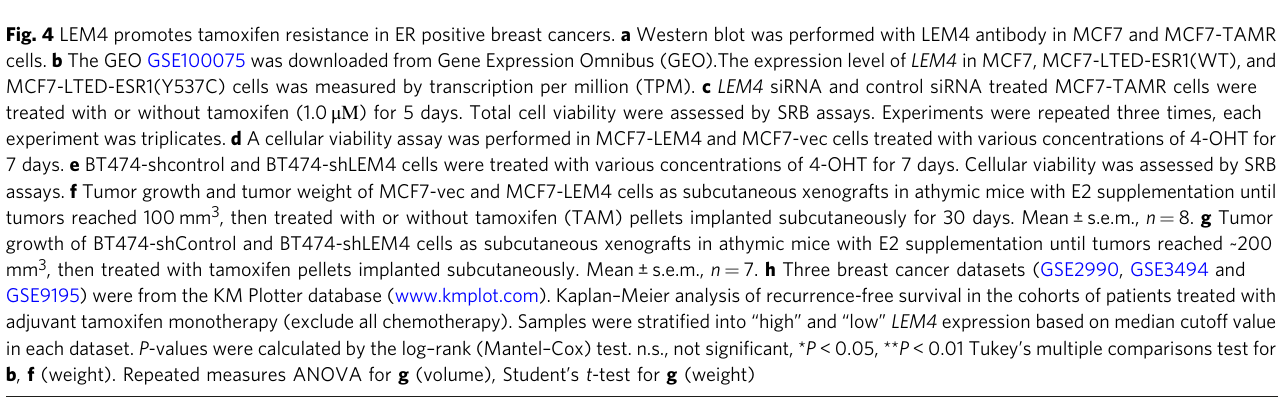
Fig. 4 LEM4 promotes tamoxifen resistance in ER positive breast cancers. a Western blot was performed with LEM4 antibody in MCF7 and MCF7-TAMR cells. b The GEO GSE100075 was downloaded from Gene Expression Omnibus (GEO).The expression level of LEM4 in MCF7, MCF7-LTED-ESR1(WT), and MCF7-LTED-ESR1(Y537C) cells was measured by transcription per million (TPM). c LEM4 siRNA and control siRNA treated MCF7-TAMR cells were treated with or without tamoxifen (1.0 μΜ ) for 5 days. Total cell viability were assessed by SRB assays. Experiments were repeated three times, each experiment was triplicates. d A cellular viability assay was performed in MCF7-LEM4 and MCF7-vec cells treated with various concentrations of 4-OHT for 7 days. e BT474-shcontrol and BT474-shLEM4 cells were treated with various concentrations of 4-OHT for 7 days. Cellular viability was assessed by SRB assays. f Tumor growth and tumor weight of MCF7-vec and MCF7-LEM4 cells as subcutaneous xenografts in athymic mice with E2 supplementation